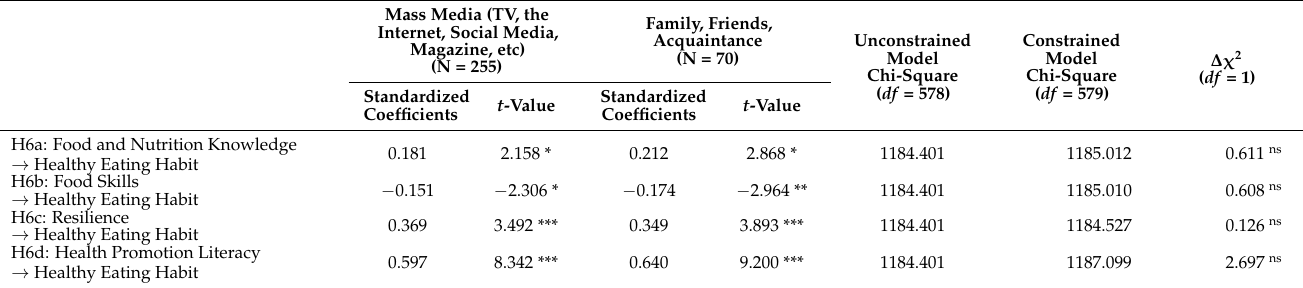
Table 7. Moderating effects on primary information